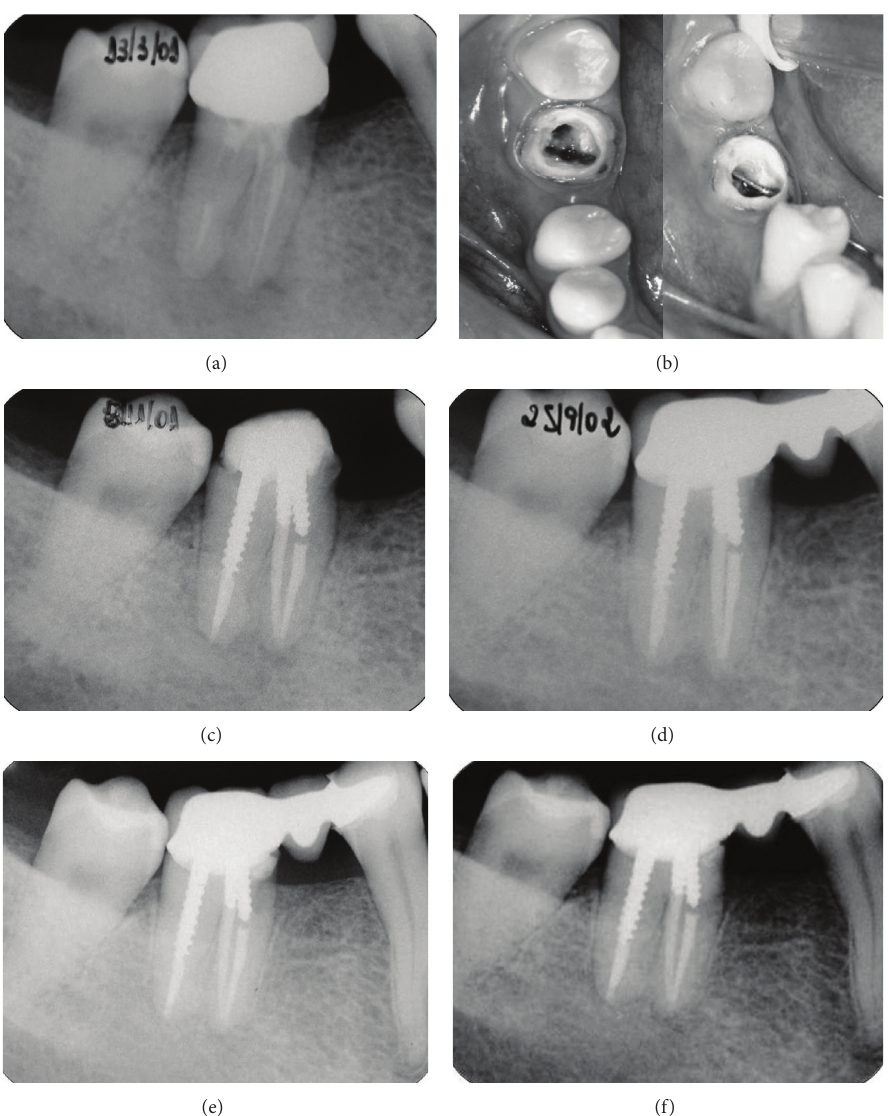
Figure 1: (a) The radiographic evaluation of case 1. (b) Clinical evaluation of the case. (c) Radiographic evaluation after perforation